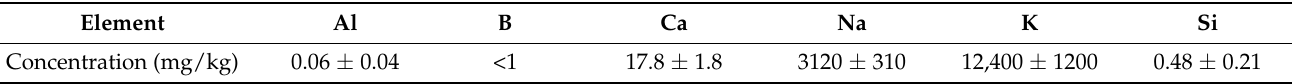
Table 1. Content of elements in the young cement water containing Ca measured by ICP-OES. Element Al B Ca Na K Si Concentration (mg/kg) 0.06 ± 0.04